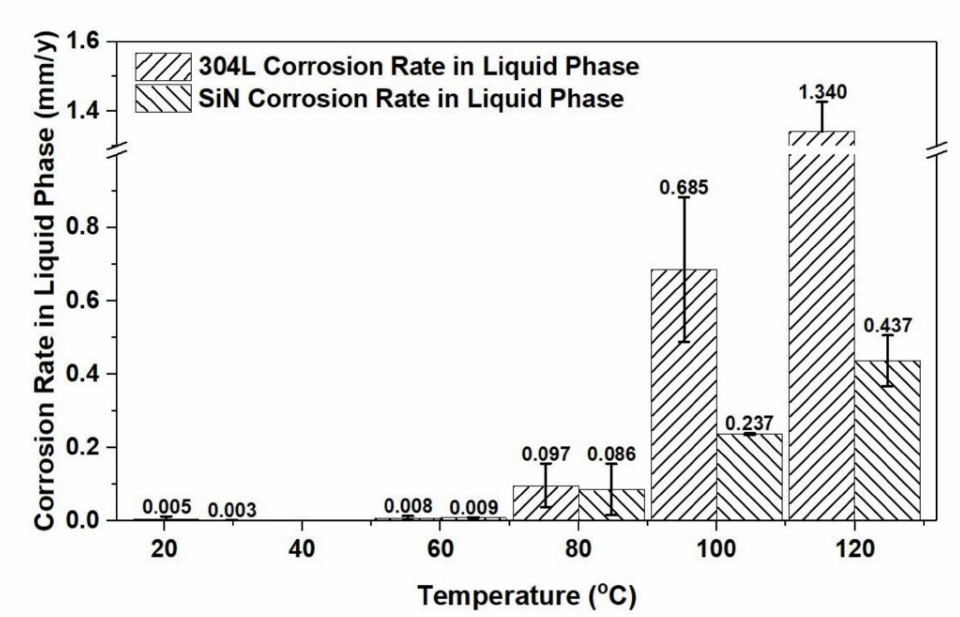
Figure 2. Corrosion rates of SiN and 304L stainless steels in nitric acid liquid phase at different temperatures.